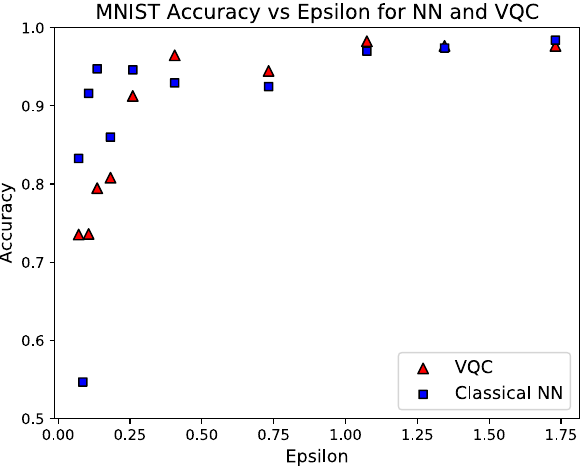
Figure 13. Accuracy of DP classifiers after 30 epochs plotted against their ε for a MNIST binary classification of the handwritten digits ‘0’ and ‘1.’ With only 28% the number of parameters in the NN, the quantum classifier is at least as accurate as the classical classifier for all investigated DP levels.